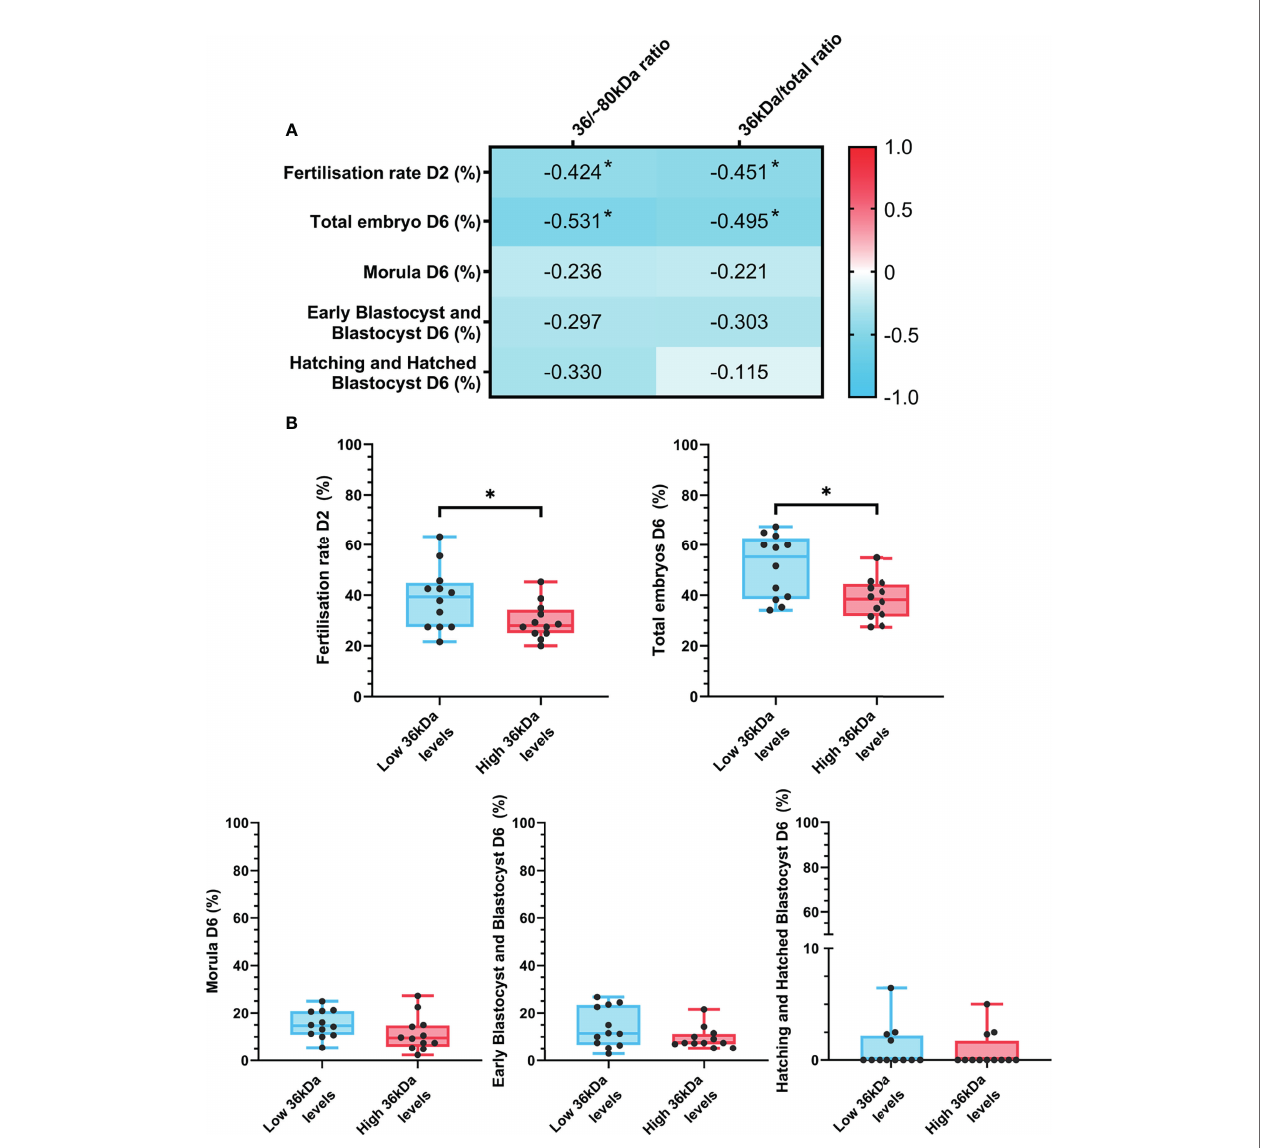
FIGURE 5 | (A) Correlation plot of in vitro fertility outcomes (evaluated as fertilization rate at day 2 and percentages of total embryos, morulas, early blastocysts/ blastocyst and hatching/hatched blastocysts at day 6) and 36/~80 kDa and 36 kDa/total ratios. In vitro fertility procedure was performed using samples from 24 AI- boars (one ejaculate per boar). The color saturation of red to blue represents the correlation coef fi cients (R) from 1 to -1, respectively. Signi fi cant correlations ( P < 0.05) are marked with *. (B) Differences between groups with high and low levels of the 36 kDa band for in vitro fertility parameters. The box indicates the maximum and the minimum of each group and the thicker line the median. Each dot represents one semen sample. Signi fi cant differences ( P < 0.05) are marked with